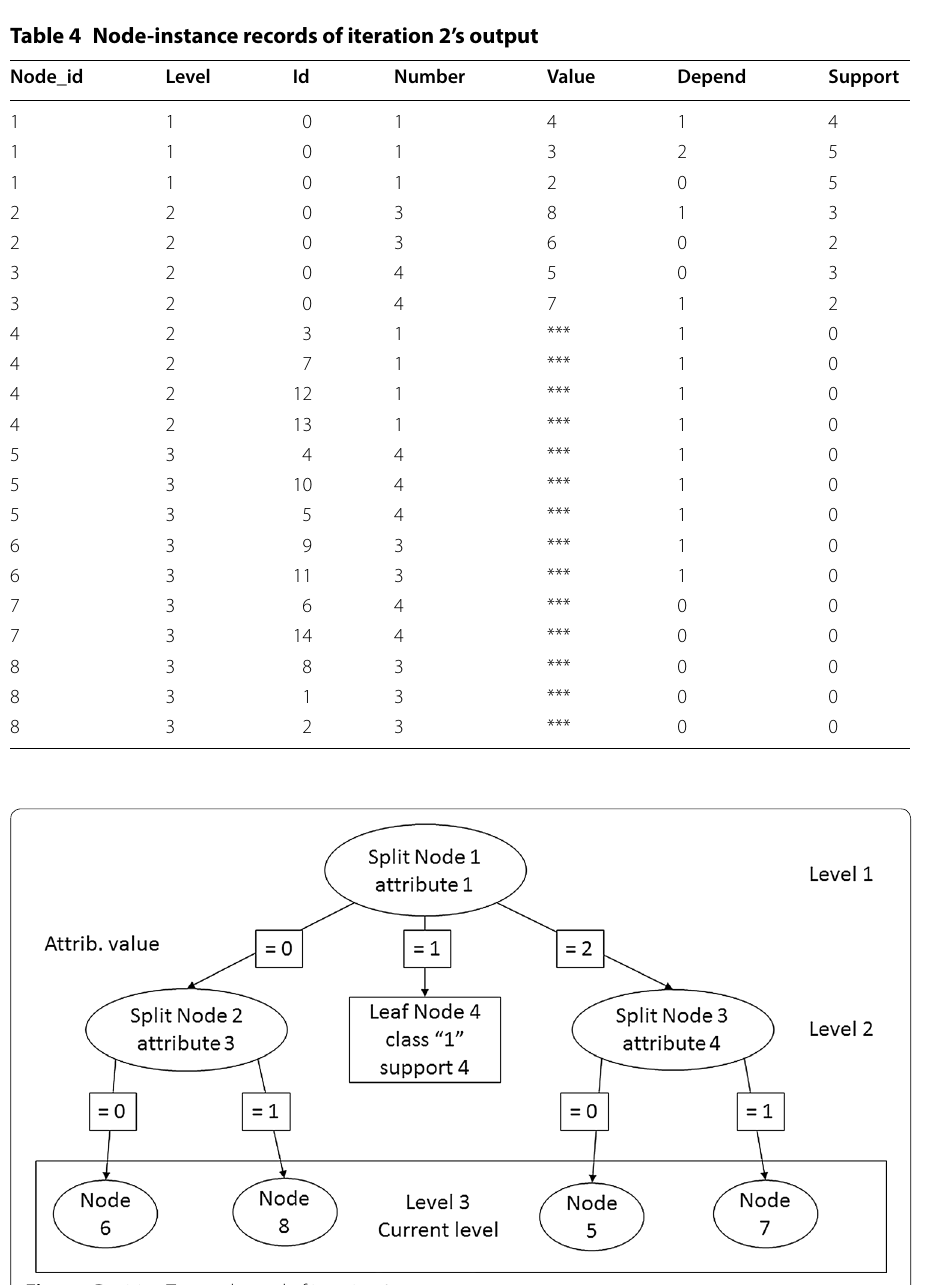
The loopbody function receives all NodeInstDisc records (shown in Table 3) that rep- resent the DT in construction at the beginning of the 2nd iteration (see Fig. 16). The location of any instance identified by “ id ” is specified by the “ node_id .” Records with “ id ” equal to zero contain split related info, although it is not possible to find such records at the current level processed. The records marked with “***” are repeated once for each attribute value to complete the whole instance data, with the number identifying the